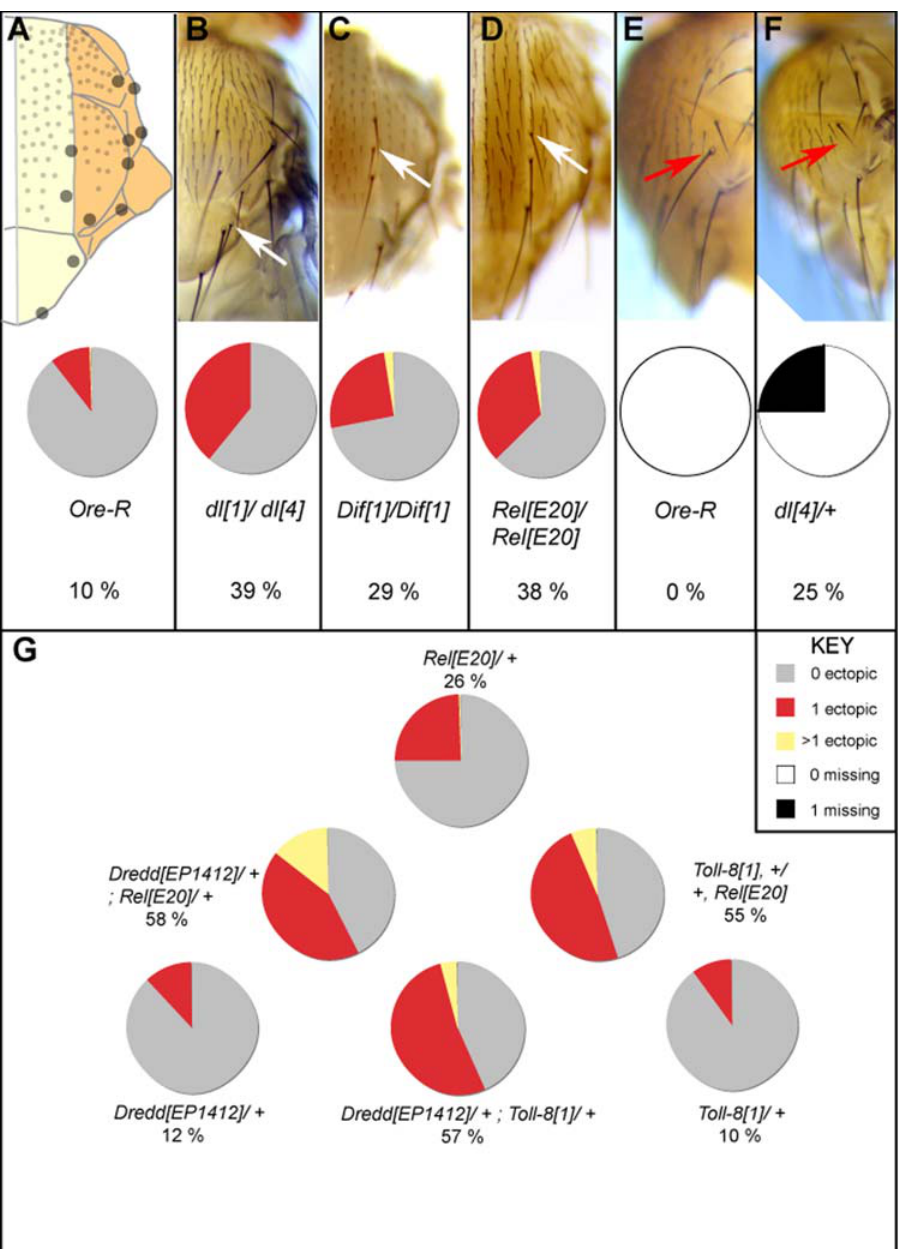
Figure 1. Loss-of-function mutants of NF k B/Relgenes display both loss and gain of macrochaetes on the notum. (A), a schematic representation of a wild-type heminotum, with the medial domain shaded yellow and the lateral domain orange. Large grey circles represent the positions of the eleven macrochaetes found on each heminotum. (B–D), heminota of flies homozygous mutant for dorsal (dl 4 /dl 1 ), Dif (Dif 1 /Dif 1 ) and Relish (Rel E20 / Rel E20 ); white arrows indicate ectopic bristles. Below, pie charts represent the percentage of heminota displaying ectopic bristles from a total of 200. Red sectors indicate the percentage with one ectopic macrochaete, yellow sectors two or more ectopic macrochaetes (p . 0.001 when compared with wild type). (E, F), heminota of Ore-R and dl 4 / + animals respectively, showing the lateral notum. Red arrows mark the pSA bristle, which is missing in a large fraction of dl 4 / + (and also dl 4 /Df(2L)TW119, dl 2 dif 2 animals) (p . 0.001). (G), the percentage of flies trans-heterozygous for various mutant combinations that display ectopic bristles (p . 0.001).